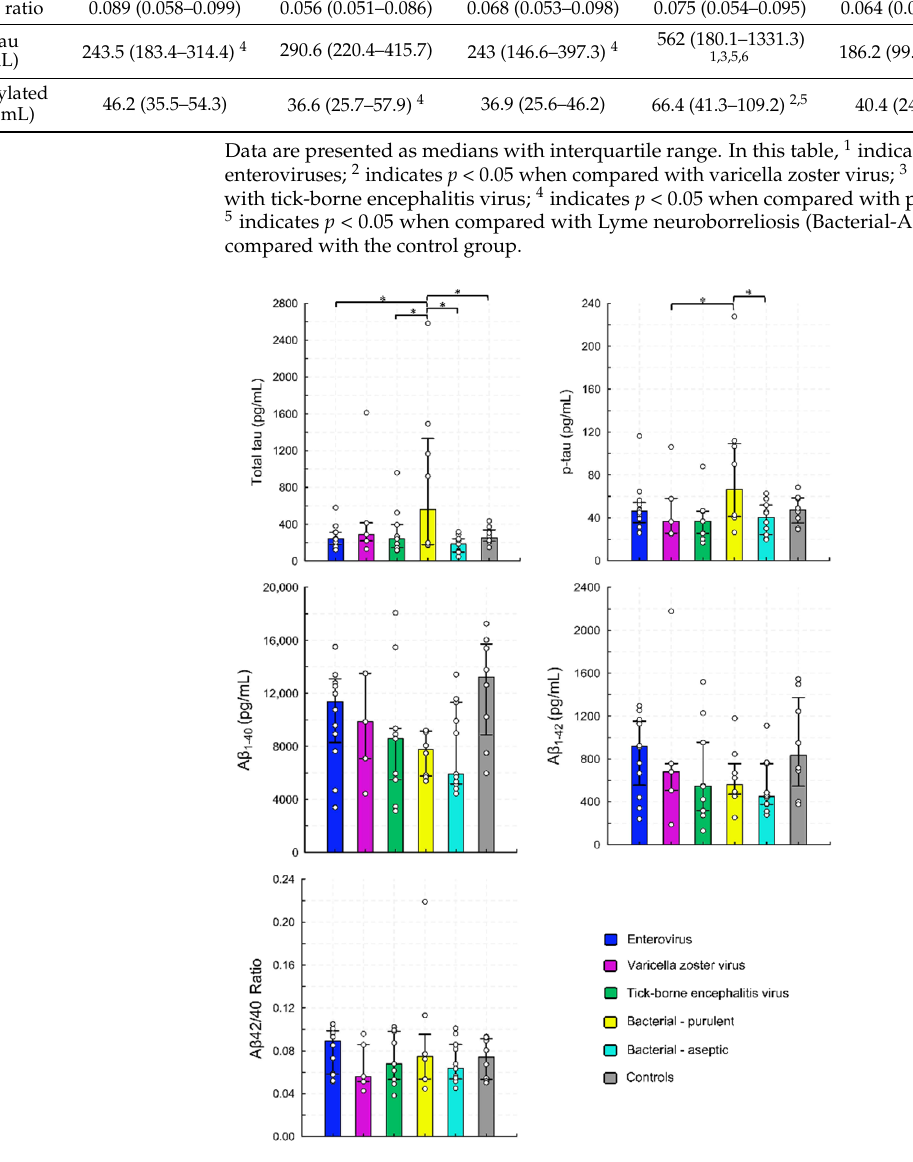
Figure 1. Cerebrospinal fluid concentrations of biomarkers of Alzheimer’s disease in children with infections of the central nervous system. Bars represent medians, whiskers represent interquartile range, and dots show the raw data. * indicates p < 0.05. Table 2. Cerebrospinal fluid concentrations of biomarkers of Alzheimer’s disease in study groups.